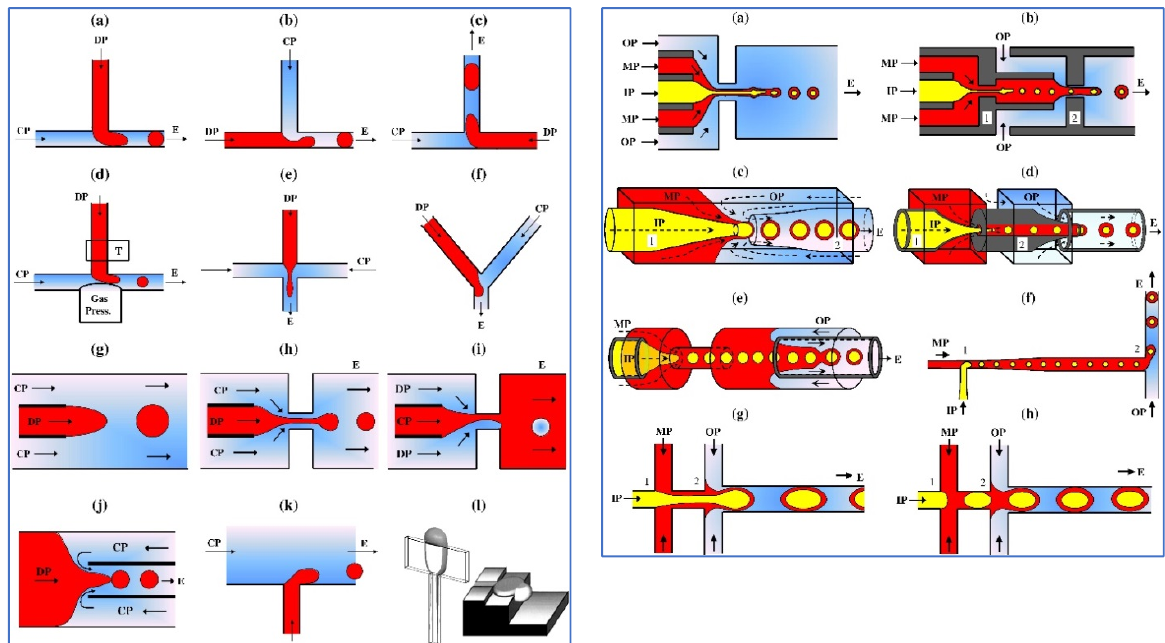
Figure 1. Various microfluidic device geometries and principles. Left panel: simple droplets made in ( a – f ) cross-flow junctions with various intersection angles; ( g ) co-flow configuration; ( h – j ) flow-focusing configurations; and ( k , l ) spon- taneous and microchannel droplet formation systems. Right panel: core-shell droplets made in ( a , b ) planar co-flow and flow-focusing configurations; ( c – e ) capillary co-flow and flow-focusing configurations; and ( f – h ) sequential cross-flow junctions. DP, dispersed phase; CP, continuous phase; E, emulsion; OP, outer phase; MP, middle phase; and IP, inner phase. Adapted from [4], with permission from Elsevier.